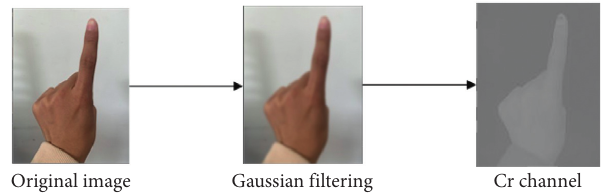
Figure 2: Skin color